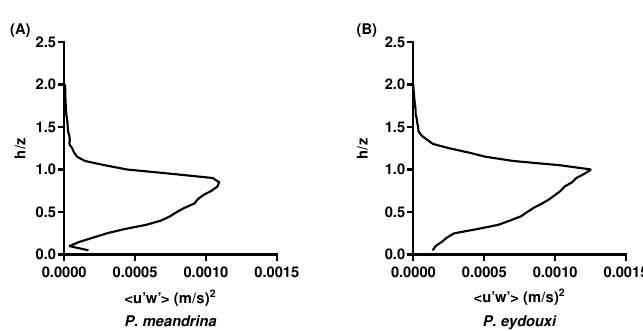
Figure 11. Mean Reynolds stress plotted as a function of normalized height above the top surface of the colony for ( A ) P. meandrina and ( B ) P. eydouxi at a Reynolds number of 15,000. Similar Reynolds stresses were observed above both colonies, despite their differences in branching patterns.